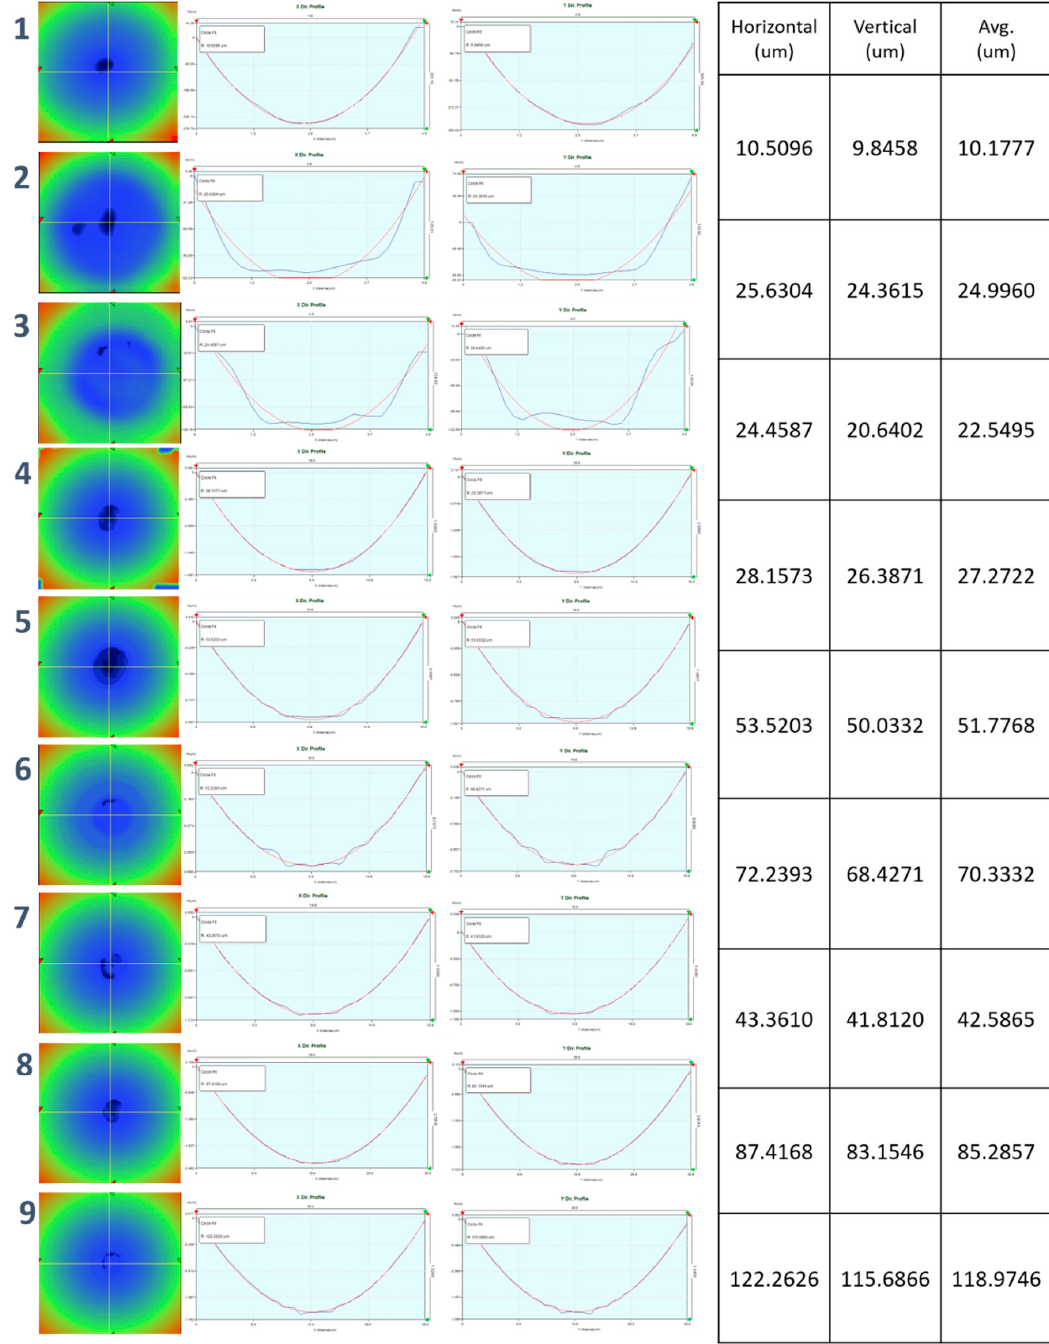
Figure A18. ROC measurement data for 5th final product replica (OM 625).